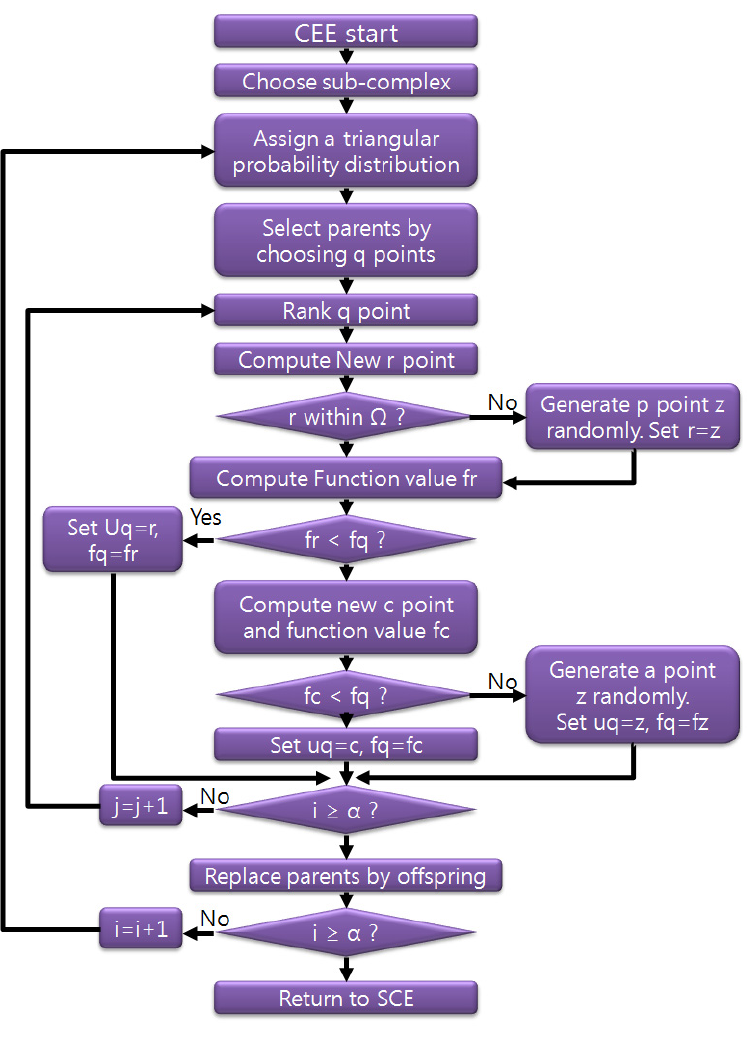
Figure 4. Flow chart of CCE subroutine in SCE-UA algorithm [2].